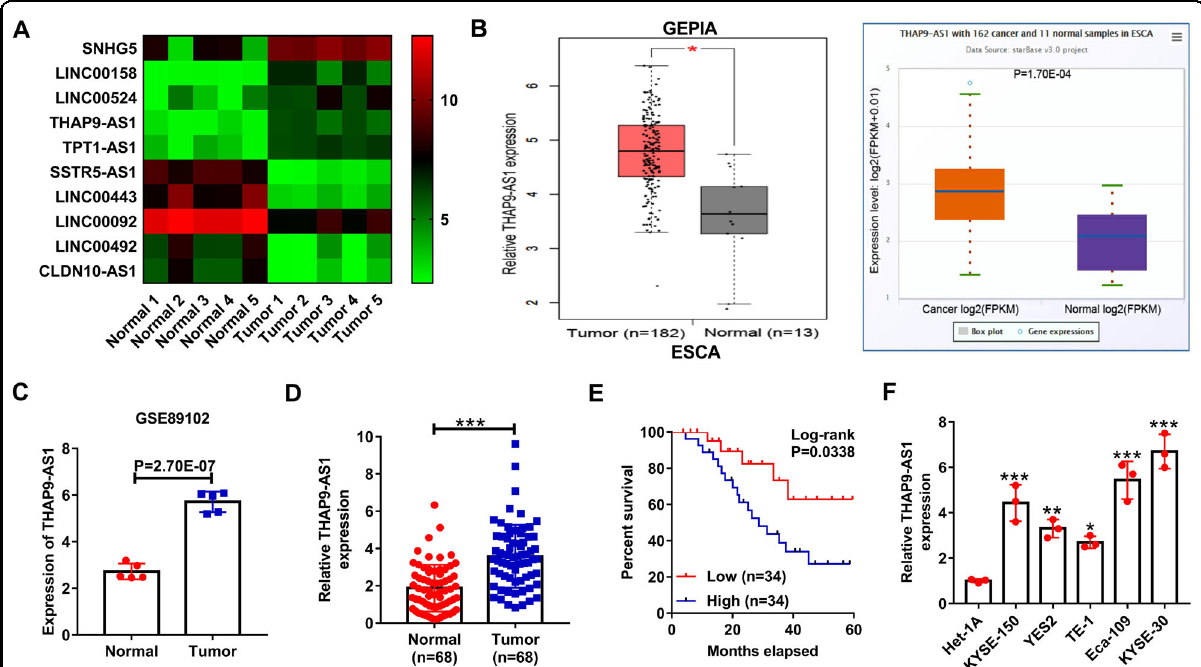
Fig. 1 THAP9-AS1 is upregulated and associated with a poor prognosis in ESCC. A 5 upregulated and 5 downregulated lncRNAs were displayed by heat map according to microarray dataset (GSE89102) containing 5 ESCC tumor tissues neighboring non-cancerous tissues. B The expression pro fi le of THAP9-AS1 in esophageal carcinoma from TCGA by using GEPIA and starBase. C Microarray data from GSE53625 showed the expression difference of THAP9-AS1 in ESCC tumor tissues and adjacent normal tissues. D qRT-PCR analysis was performed to measure the expression of THAP9-AS1 in tumor tissues and corresponding nonneoplastic tissues from 68 ESCC patients. E Kaplan-Meier survival curve was utilized to evaluate the correlation between THAP9-AS1 expression and clinical outcome of ESCC patients. F Expression of THAP9-AS1 in ESCC cell lines (KYSE-150, YES2, TE-1, Eca-109, KYSE-30) and normal esophageal epithelial cell line Het-1A was determined by qRT-PCR. * P < 0.05, ** P < 0.01, *** P <